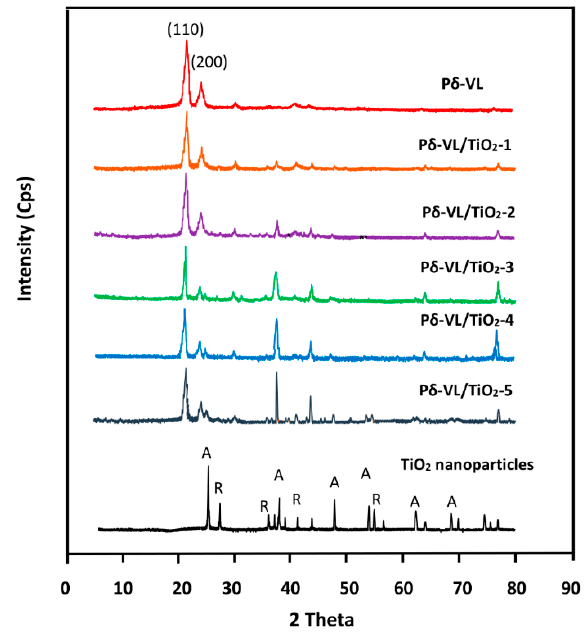
Figure 2. XRD patterns of pure TiO 2 nanoparticles, virgin P δ -VL and P δ -VL/TiO 2 nanocomposites with different TiO 2 loads.